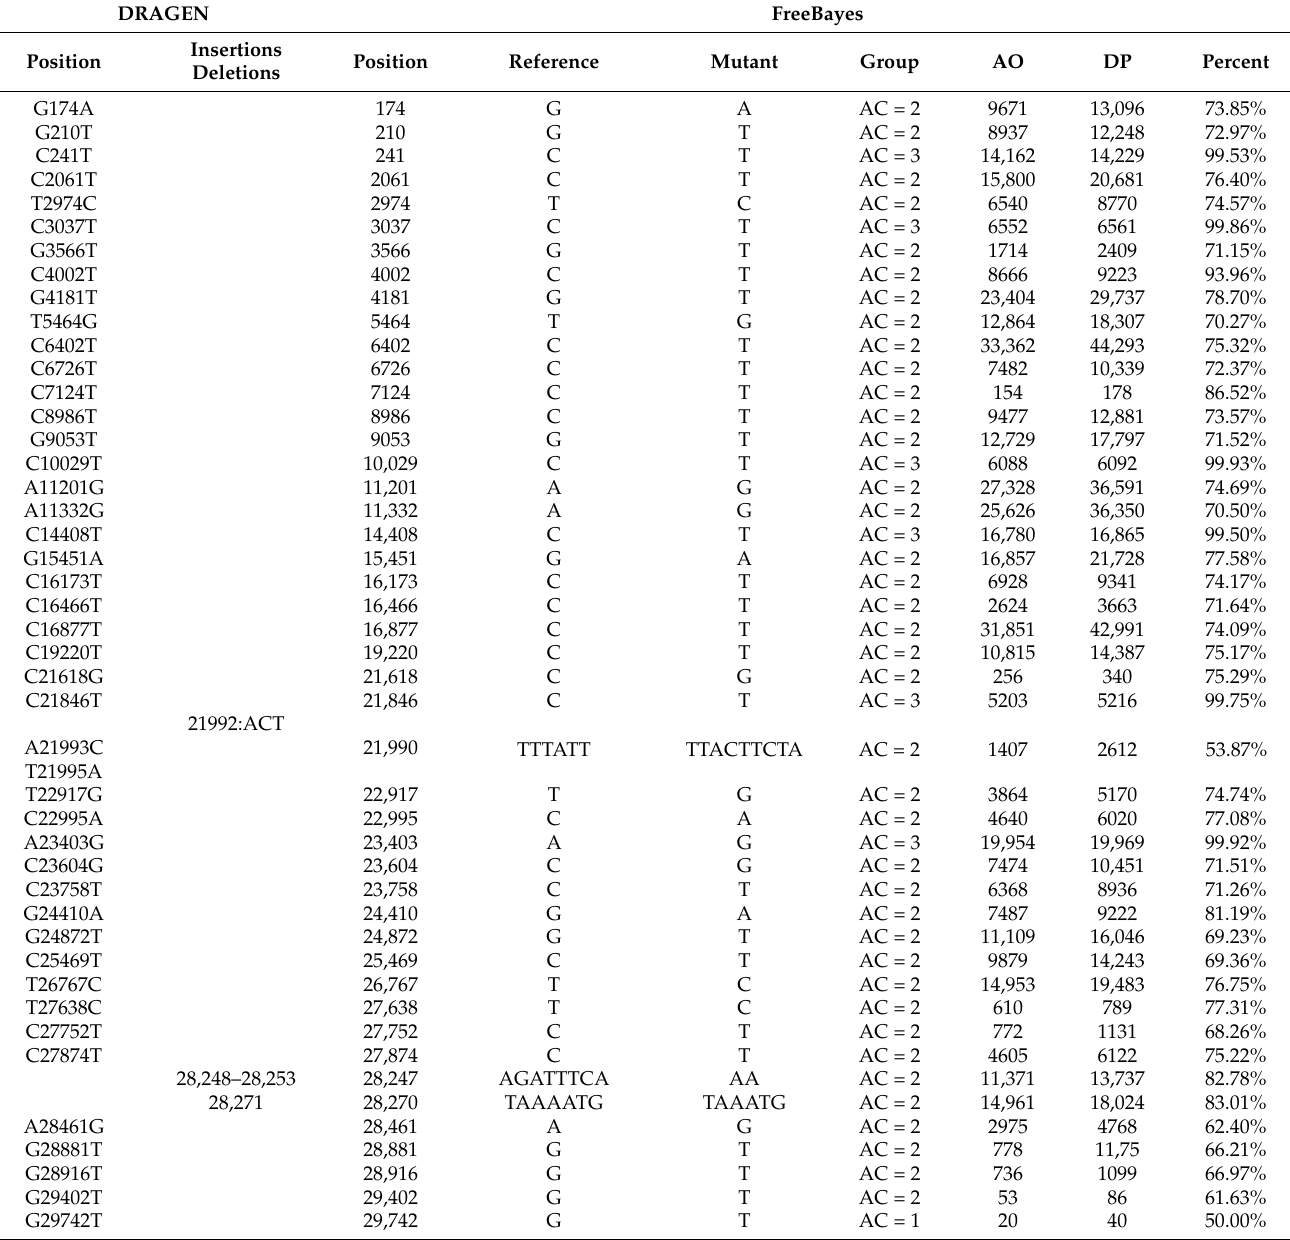
Table 5. Mutations detected by Illumina DRAGEN COVID Lineage v3.5.3 and FreeBayes in sample